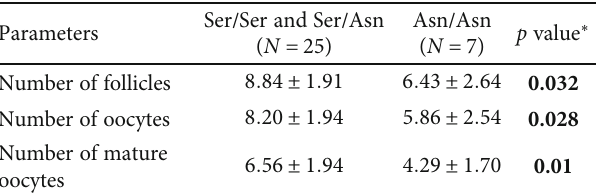
Table 2: Comparison of clinical pro fi les of women based on whether or not they carry the Ser allele in their genotype. ∗ Mann- Whitney U